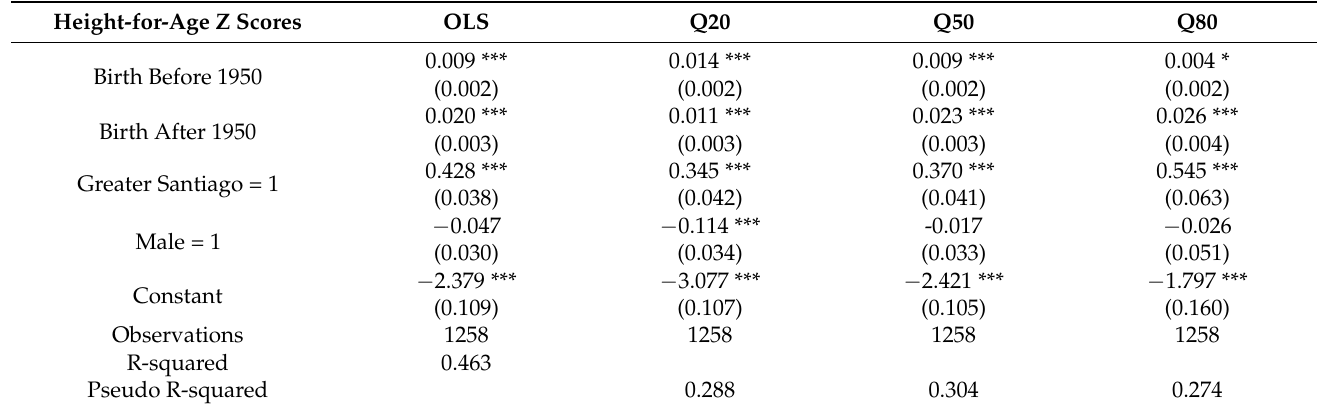
Table A4. OLS and quantiles regressions with breaks in